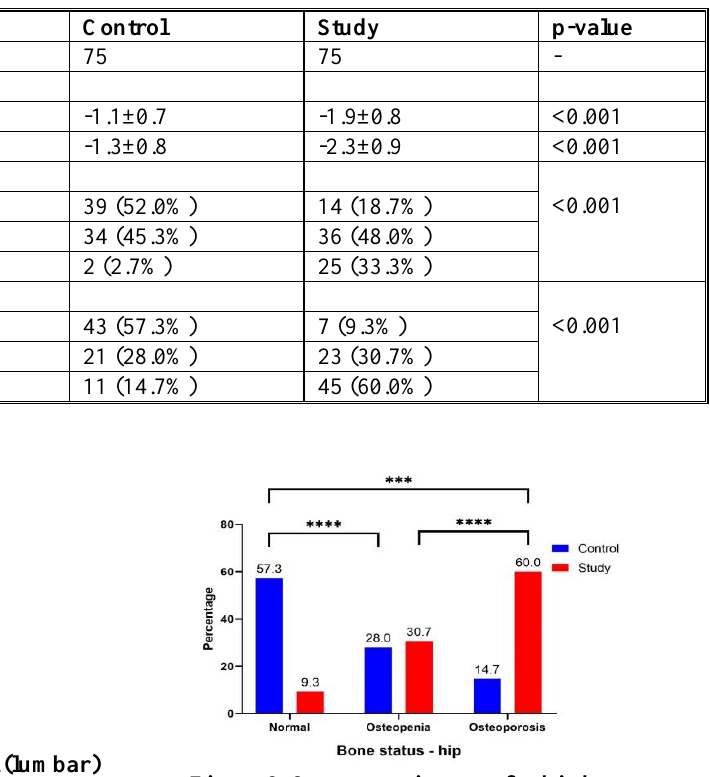
Figure.2. Osteoporosis status for hip bone *** Highly significant difference (p-value < 0.001) **** Very highly significant difference (p-value < 0.0001) predictors of osteoporosis for hip bone, as illustrated in table 4